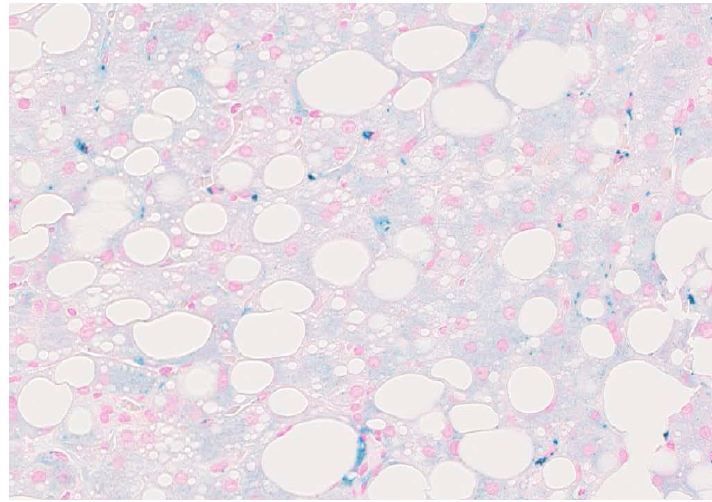
Figure 1. Histopathology from a patient with alcoholic liver disease (ALD) shows pathological iron accumulation. Prussian blue stain from a liver biopsy of a 47-year old male patient with clear features of ALD (macrovesicular lipid droplets) and iron deposits (blue stain in hepatocytes and Kupffer cells). The carcinogenic potential of tissue iron accumulation is highly attributed to Fenton-like reactions which occur in the presence of ferrous iron and H 2 O 2 , yielding to highly reactive hydroxyl